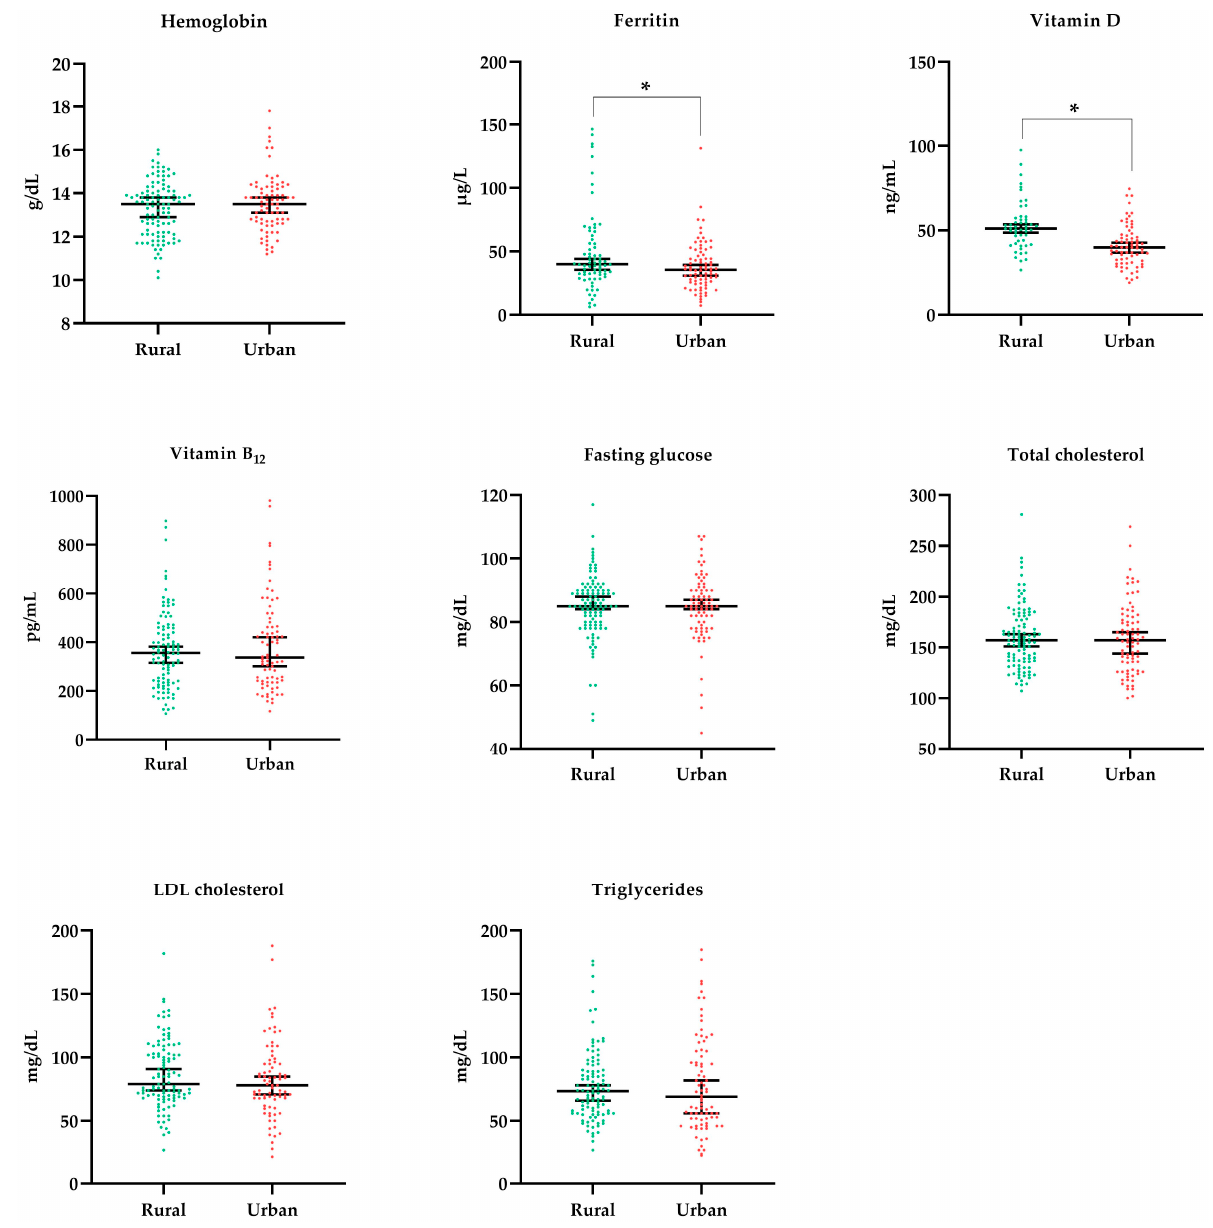
Figure 3. Laboratory characteristics of the participants according to school location. Statistical test: Mann–Whitney. * Statistically significant differences ( p < 0.05). Table 2. Absolute and relative frequencies of laboratory inadequacies in school children in rural and urban areas.